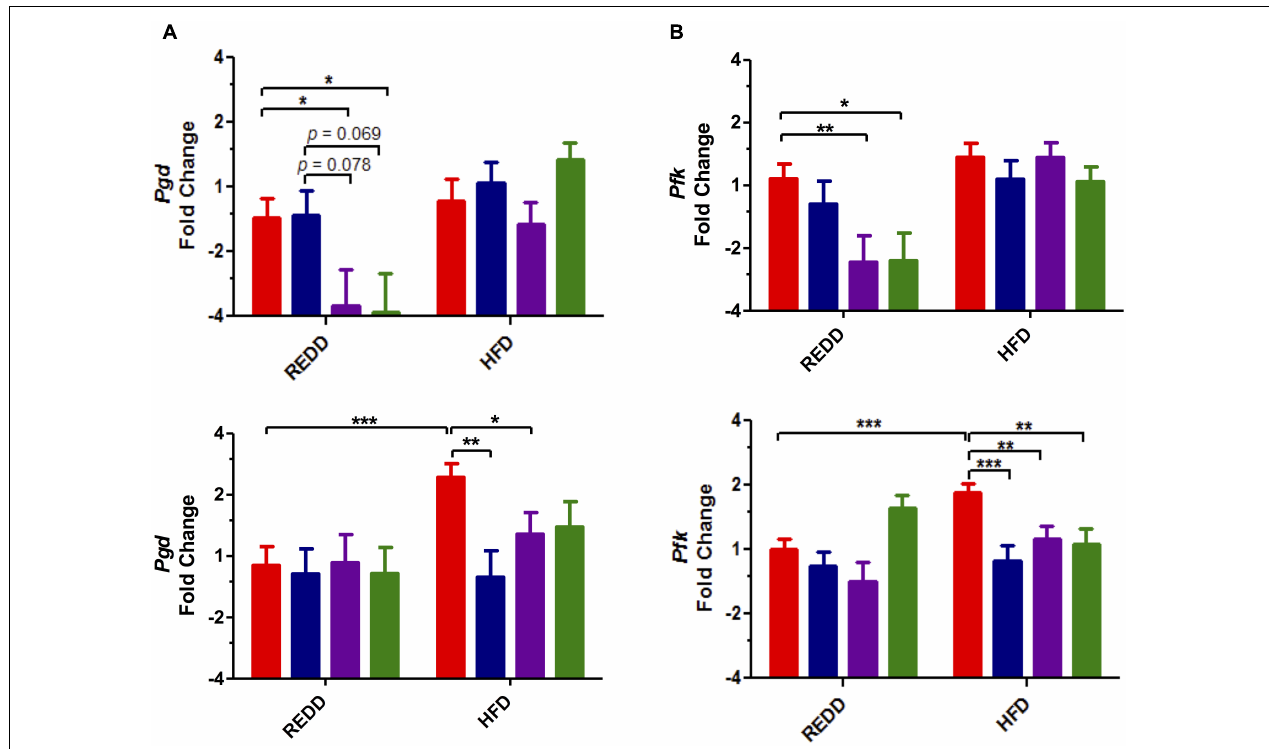
FIGURE 6 | Treatments affect the transcription of mTORC1-activated genes in the stomach. (A) Pgd gene (B) Pfk gene expression quantified by qRT-PCR in male (top) and female (bottom). Rplp0 was used as an internal standard. Results are expressed as Log 2 (Fold Induction) with repression values (i.e., < 1) expressed as its negative reciprocal (i.e., 0.5 = − 2). The number of animals analyzed for REDD Control, REDD + BBE, REDD + Ljo, REDD + BBE + Ljo, HFD Control, HFD + BB, HFD + Ljo, HFD + BBE + Ljo are as follows: Pgd Male, n = 9, 5, 8, 7, 5, 5, 7, 7, respectively, Pgd Female, n = 9, 6, 4, 5, 9, 5, 5, 3, respectively, Pfk Male, n = 10, 5, 8, 7, 9, 6, 8, 10, respectively, Pfk Female, n = 10, 6, 4, 4, 9, 5, 5, 4, respectively. Numerical data are summarized as means ± SEM. ∗ p < 0.05, ∗∗ p < 0.01, ∗∗∗ p < 0.001. Red bar, control; blue bar, blueberry extract; purple bar, L. johnsonii ; green bar, blueberry extract + L. johnsonii . REDD, reduced energy density diet; HFD, high fat